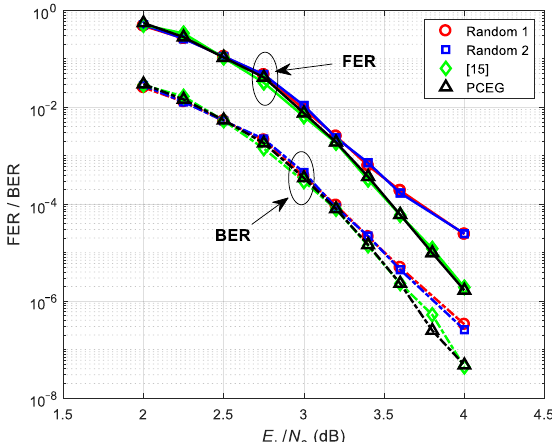
Figure 12. Performance of NB- LDPC codes over GF(64) with the code length of 576 bits and the code rate of